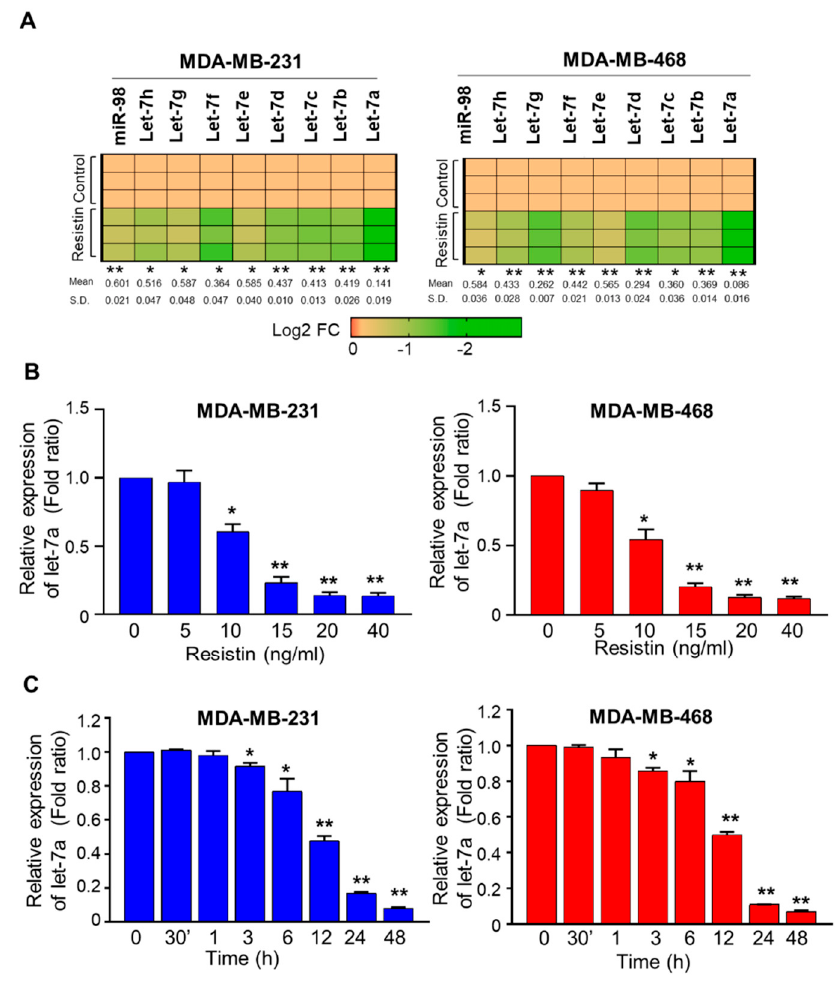
Figure 1. Effect of resistin on Let-7a expression. ( A ) MDA-MB-231 and MDA-MB-468 BC cells were treated with resistin, and the expression of Let-7 family miRNAs was analyzed by qRT-PCR. ( B ) Dose-dependent regulation of Let-7a by resistin (0–40 ng/mL) examined after 24 h. ( C ) Time-course of Let-7a downregulation following treatment with resistin (20 ng/mL). Error bars represent the mean ± SD; n = 3, * p < 0.05, ** p < 0.001. U6 was used as an internal control for the